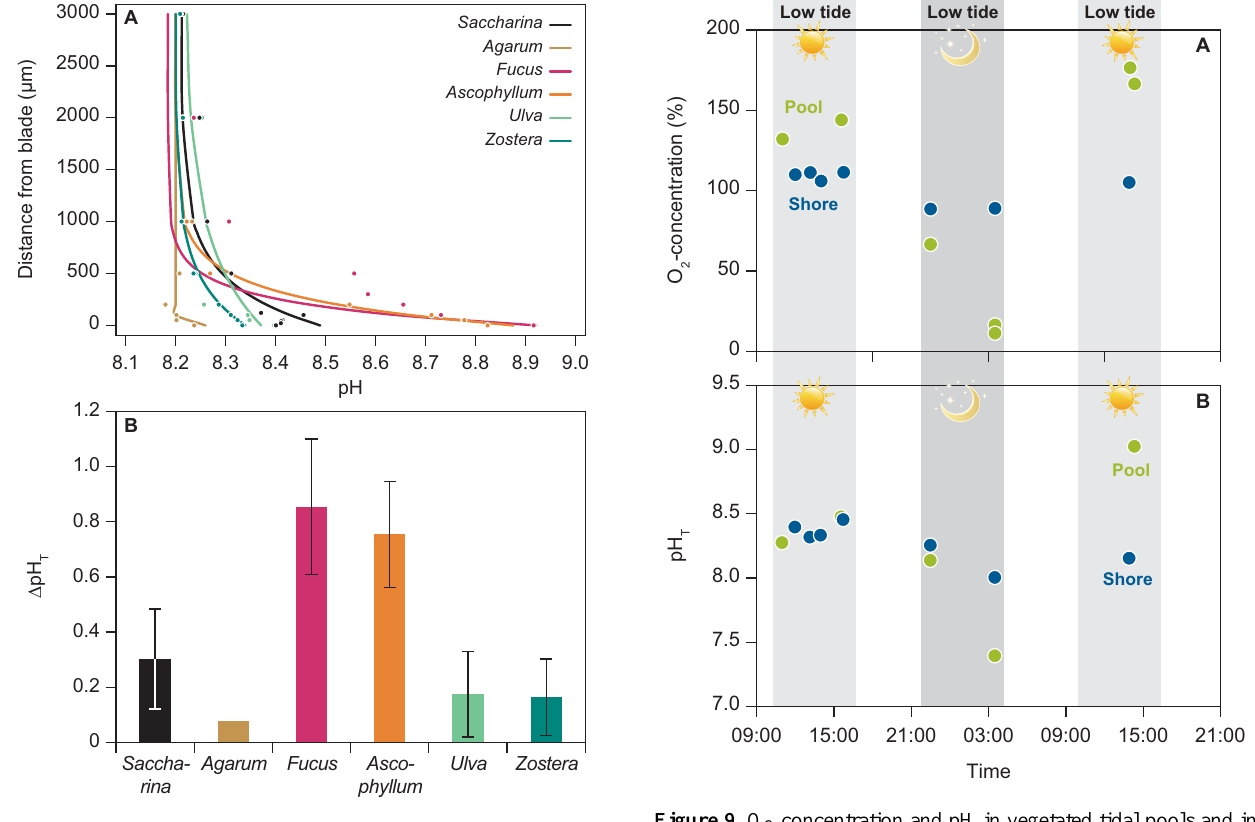
Figure 8. Microscale pH variability across diffusive boundary lay- ers of blades of six different macrophyte species illuminated by 200µmol photons m − 2 s − 1 : the kelps Saccharina longicruris and Agarum clathratum , the intertidal brown macroalgae Fucus vesicu- losus and Ascophyllum nodosum , the green macroalga Ulva lactuca , and the seagrass Zostera marina . (a) pH levels (mean of 2–3 repli- cate measurements) across blade diffusive boundary layers fitted by an exponential model ( y = y 0 + a × exp − b × x , R 2 > 0.90 for all in- dividual fits). (b) pH range across the diffusive boundary layer of the various species.